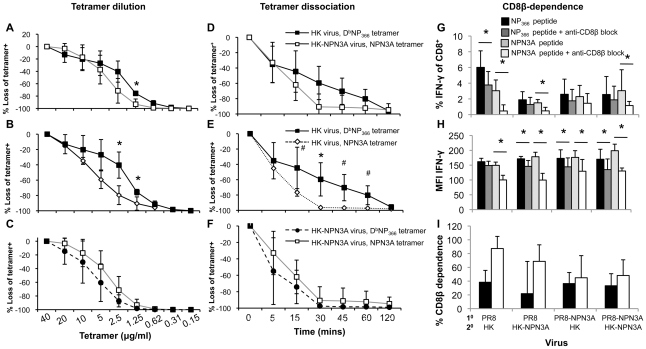
Decreased pMHC avidity and CD8β-independence for functional avidity of DbNPN3A-primed T cells for DbNP366.pMHC-TCR avidity was assessed by three measures: (A–C) the overall pMHC avidity (tetramer “on” and “off” rates) by tetramer dilution, (D–F) tetramer “off”-rate by tetramer dissociation and (G–I) CD8β-dependence by anti-CD8β blocking combined with ICS. Splenocytes were obtained from mice 2o-challenged with wt or NPN3A viruses. (A–C) DbNP366
+ CD8+ and DbNPN3A CD8+ T cells were stained with 2-fold dilutions of PE-conjugated tetramers, followed by anti-CD8 staining. (D–F) Cells were stained with either the DbNP336 or DbNPN3A tetramers at the saturating concentration, then incubated at 37oC with a mAb to H2Db to prevent rebinding of dissociated tetramer. The progressive diminution in tetramer staining was measured by flow cytometric analysis. (G–I) Lymphocytes were pre-cultured in the presence or absence of anti-CD8β antibody (53.5-8) (10 µg/ml). Cells were then stimulated for 5 h with peptide, IL-2 and GolgiStop also in the presence or absence of anti-CD8β antibody (5 µg/ml). Following stimulation, cells were analysed for CD8 and IFNγ expression. Shown is (G) the percentage of CD8+ T cells producing IFN-γ in the presence or absence of anti-CD8β blocking mAb, (H) mean fluorescence intensity (MFI) of IFN-γ staining, (I) the percentage of CD8+ cells dependent on anti-CD8β for IFN-γ production. Tetramer staining was performed in the presence of NaAz, then washed and incubated with anti-CD8 mAb. The progressive diminution in tetramer staining was measured. The Td50 value defining the time to 50% tetramer loss. Data represent mean±SD (n = 4–5 mice per group), *p<0.01; #p<0.05.